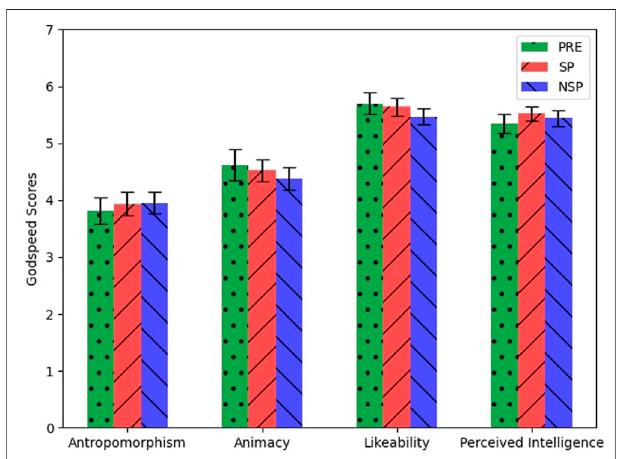
FIGURE 8 | Average and standard error of participants ’ answers to the Godspeed